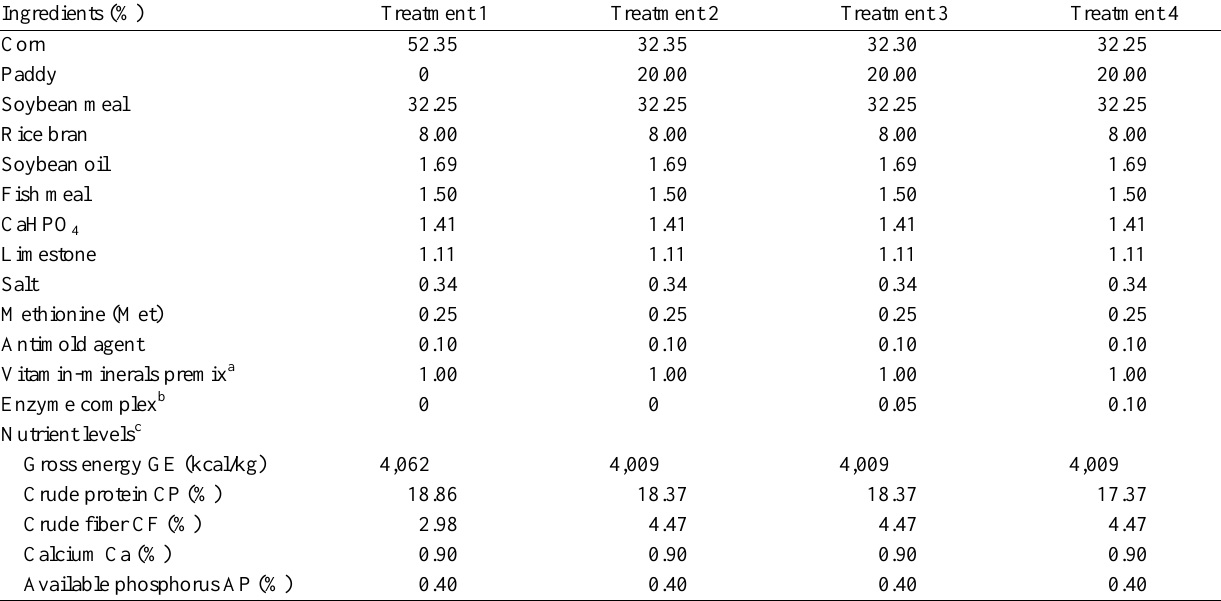
Table 1. Composition and nutrient content of